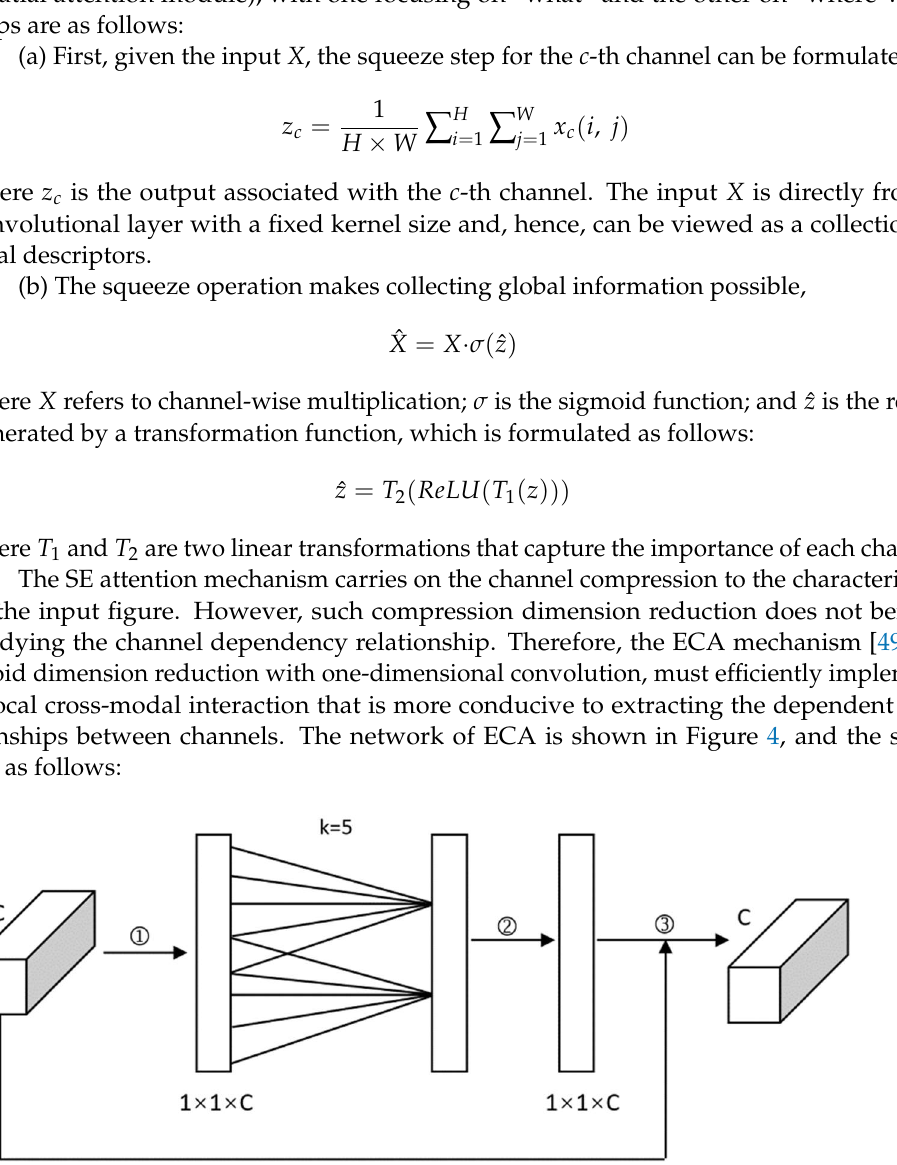
Figure 4. The network of ECA ( ○ 1 : given the aggregated features obtained by global average pooling (GAP); ○ 2 : 𝜎 ; ○ 3 :